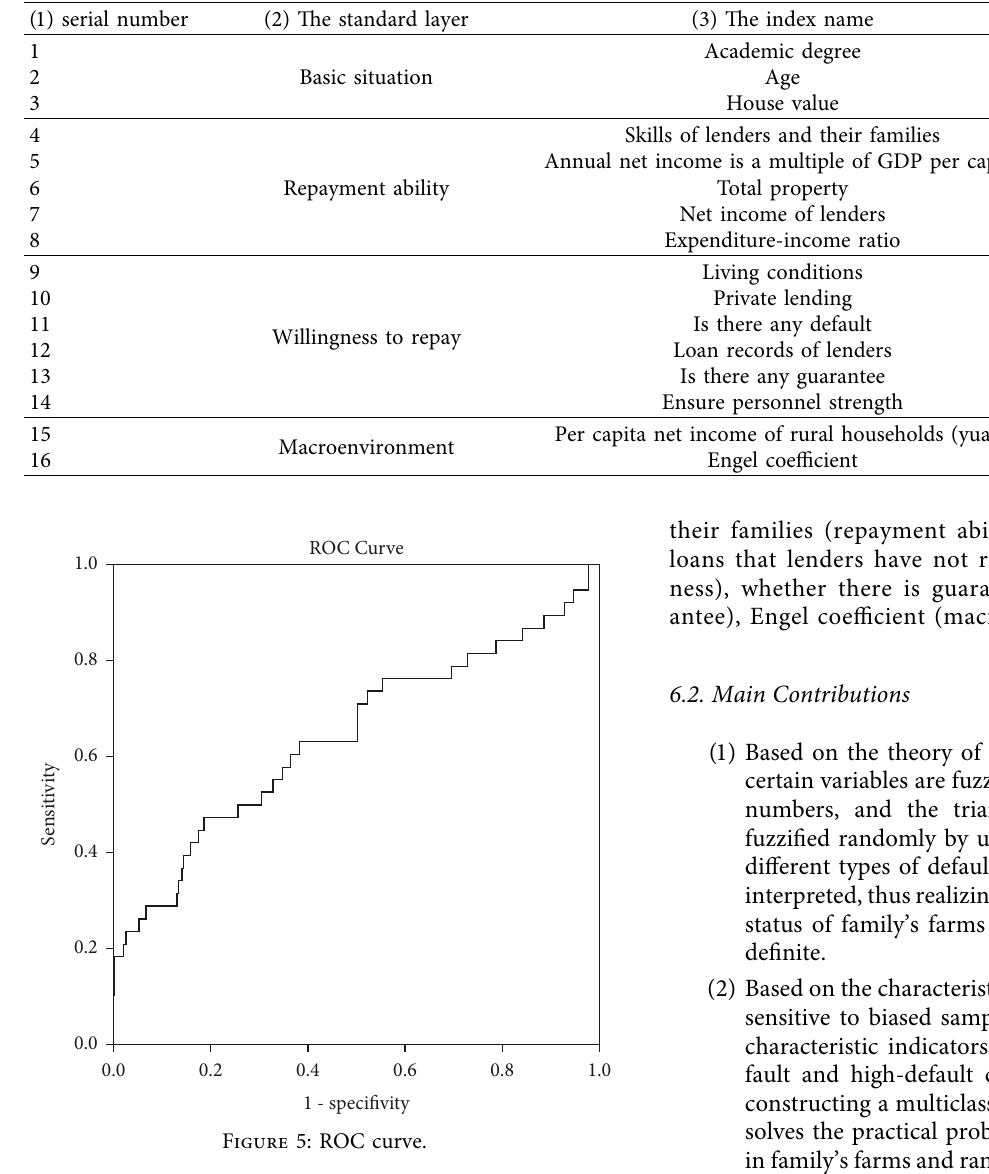
Table 5: Credit evaluation indicator system.